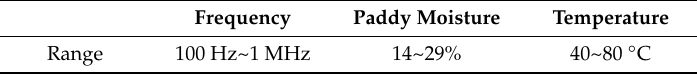
Table 1. Ranges of research parameters.